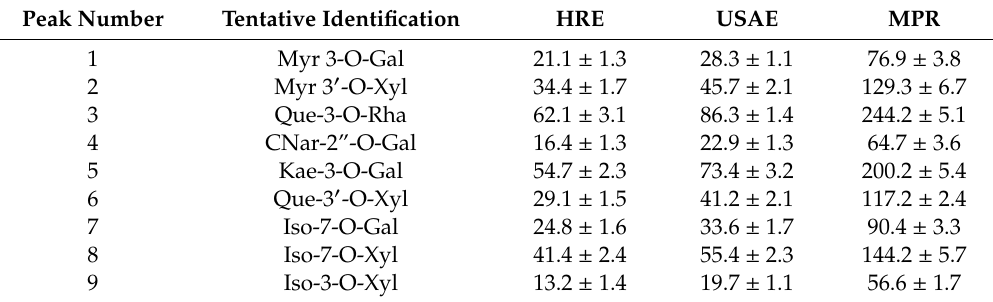
Table 6. Relative quantification of the different flavonoid glucosides in the N. lotus stamen extracts. Peak Number Tentative Identification HRE